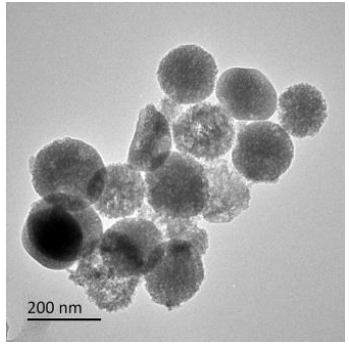
Figure 7. The TEM photograph of sc-PLAG-5%.